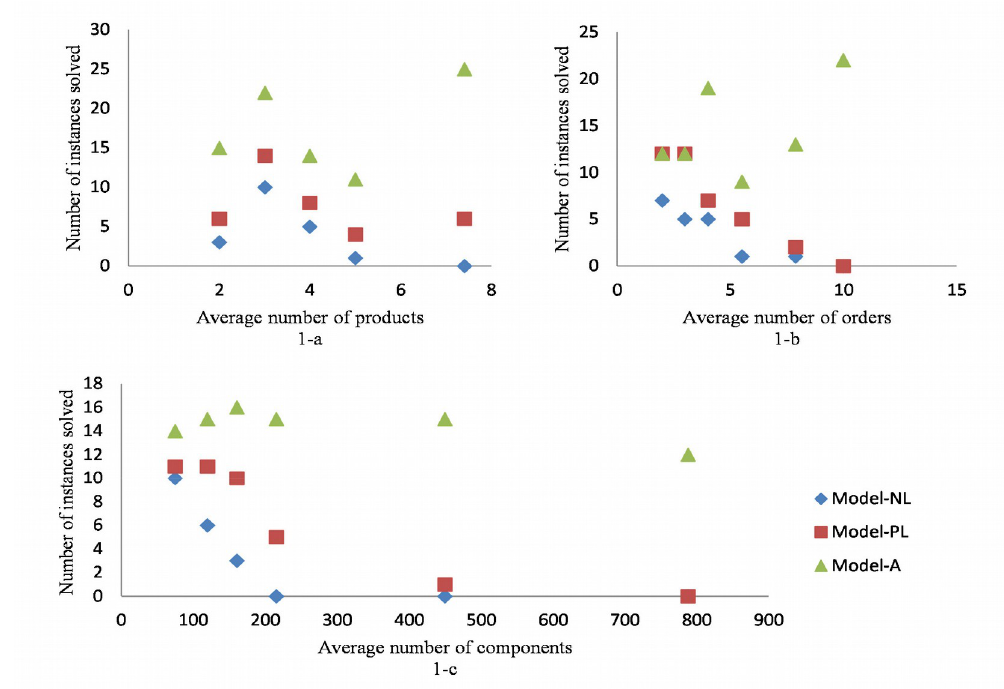
Figure 1. Comparison of Model-NL, Model-PL, and Model-A according to the varying ranges of number of products (1-a), number of orders (1-b) and number of components